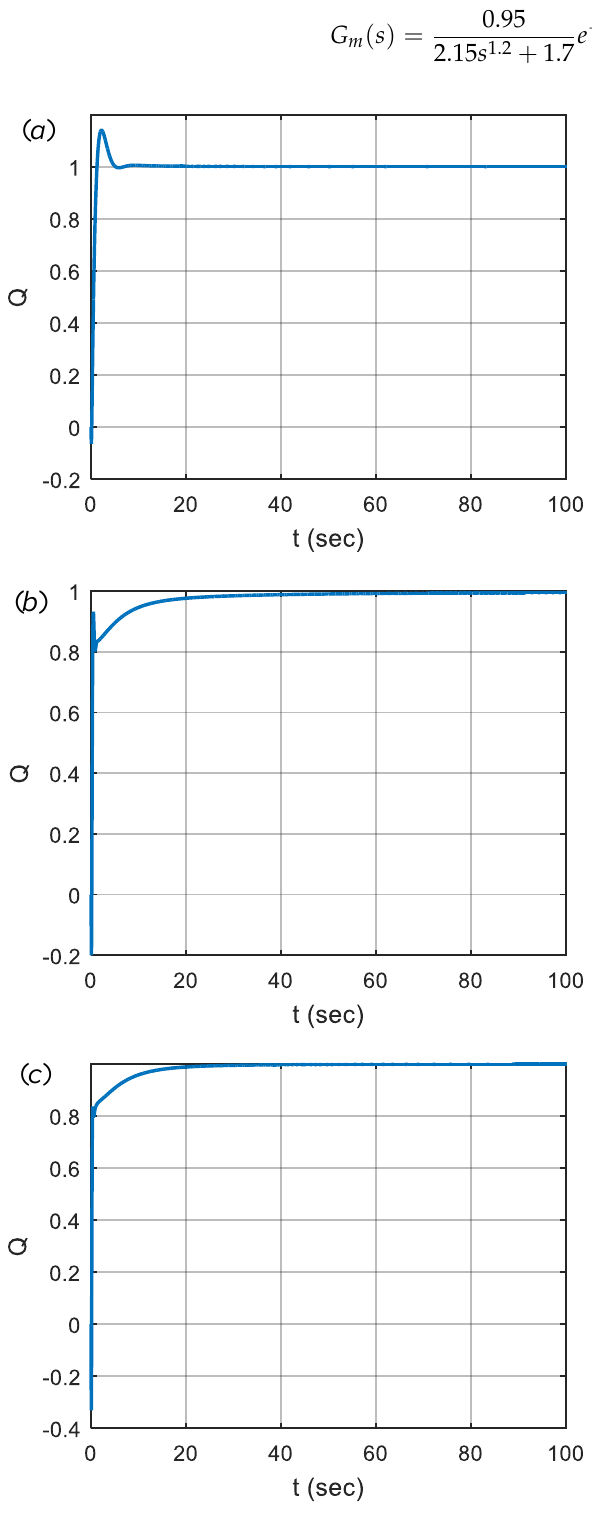
Figure 11. Step responses of stabilized FOPID control systems for target angle specifications ( a ) for